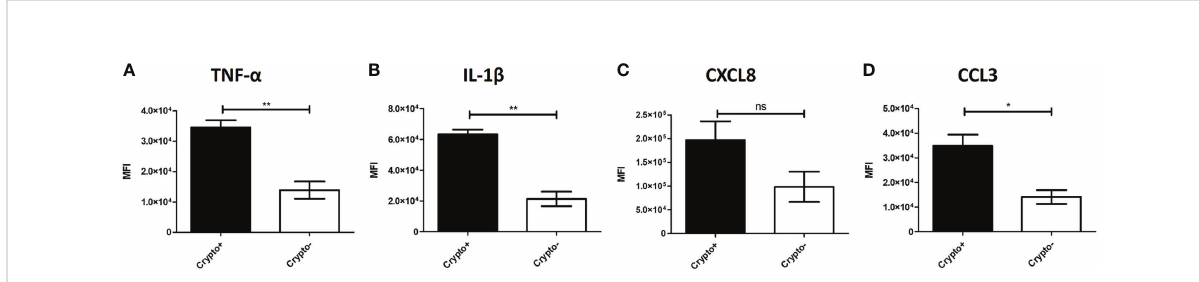
FIGURE 9 Phagocytic APCs Incubated with C neoformans Show Differential TNF- a and Downstream Protein Expression Following Fungal Interaction. Processed human BAL cells were enriched for phagocytic APCs and incubated with mCherry expressing C neoformans strain JLCN920 for 2h and then processed for imaging fl ow cytometric analysis. Analysis shows that increased presence of protein expression of TNF- a (A) , IL-1 b (B) , and CCL3 (D) occur when interaction with cryptococcal cells was veri fi ed compared to non-interacting cells. CXCL8 (C) shows a similar but non-signi fi cant trend, as well. Data shown are mean fl uorescent intensities (MFI) of individual viable CD45 + phagocytic APCs from three individual experiments (n=3). Two-tailed t -tests were performed to compare pairs of columns. * and ** indicates signi fi cantly different means of p < 0.05 and p < 0.0001,